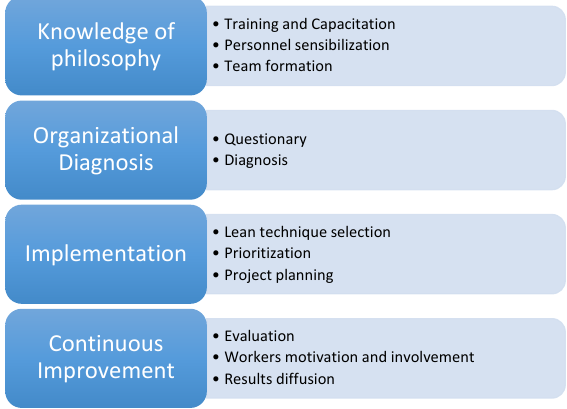
Figure 1. Proposed procedure.